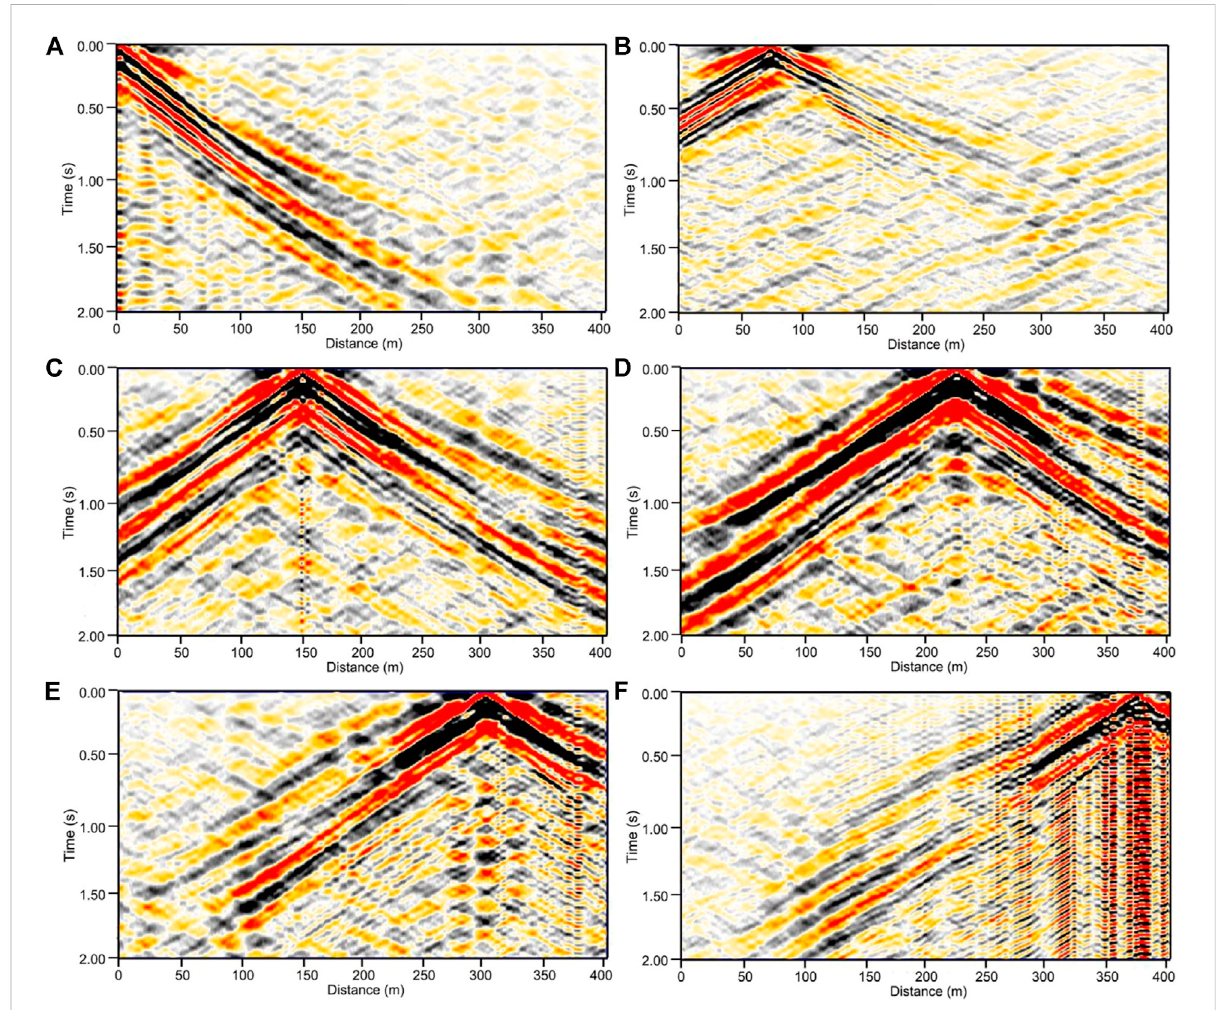
FIGURE 7 The virtual shot gather with a virtual source at (A) 2.5 m, (B) 77.5 m, (C) 152.5 m, (D) 227.5 m, (E) 302.5 m, and (F) 377.5 m.